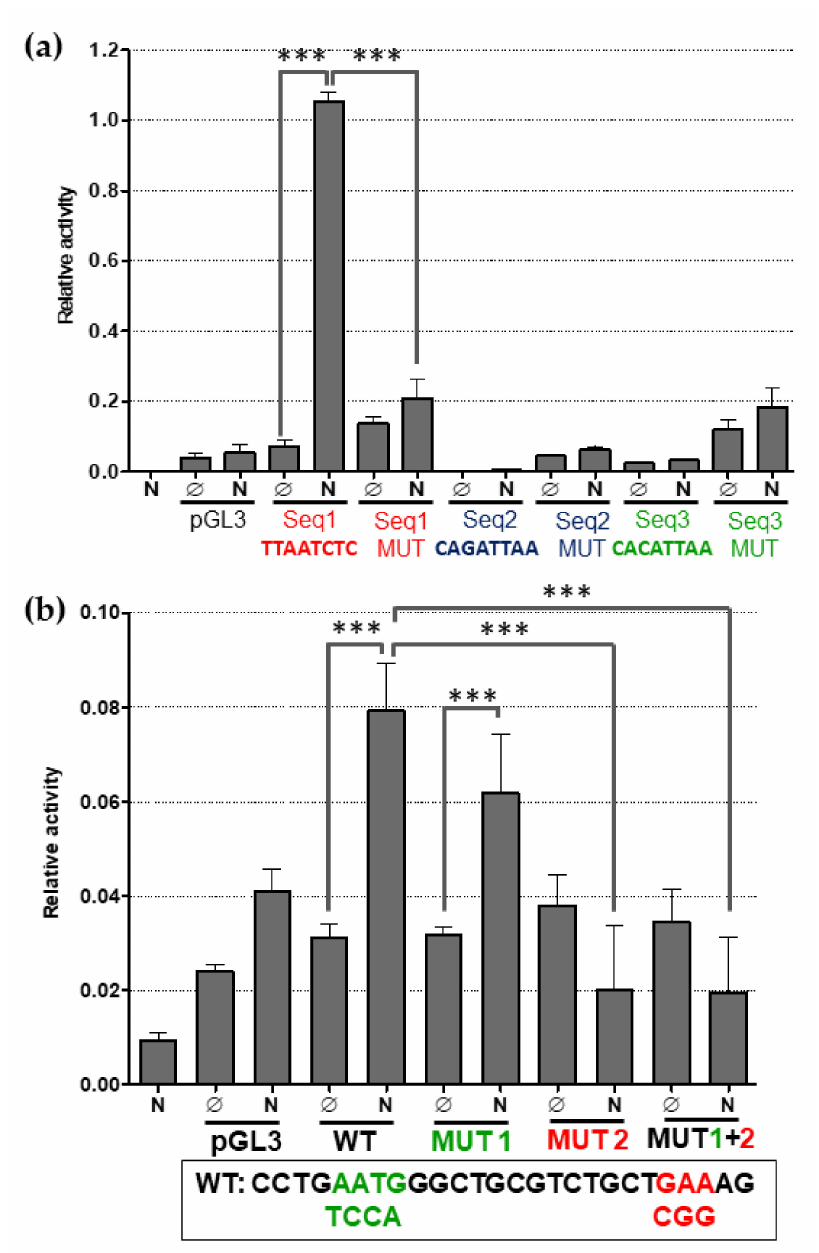
Figure 2. CXCR4 is a direct target of NANOG in human and medaka. Bar graphs showing reporter activities. ( a ) Regulation of luciferase reporter by Ol-Nanog. Ol-Nanog activates expression